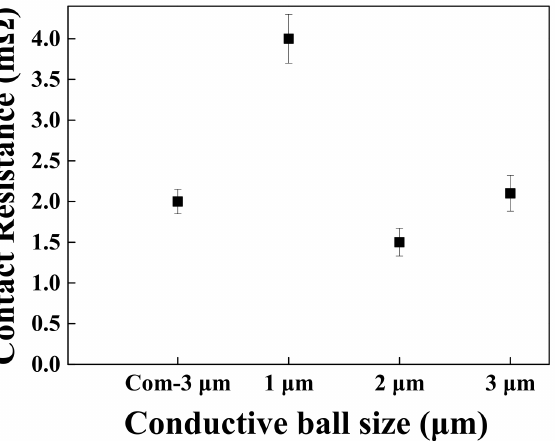
Figure 16. Contact resistance measurement graph, according to the size of the conductive